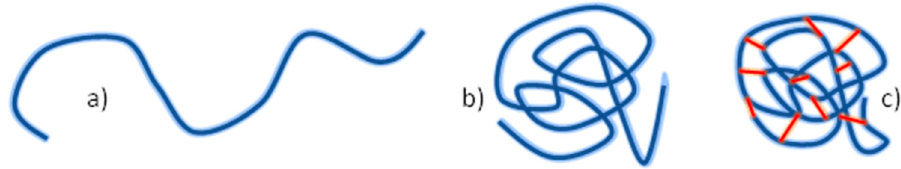
Figure 13. Nanogels as internally crosslinked polymer coils: ( a ) linear macromolecule in a stretched conformation, ( b ) linear macromolecule in a coiled conformation, ( c ) internally cross-linked polymer coil—a nanogel.